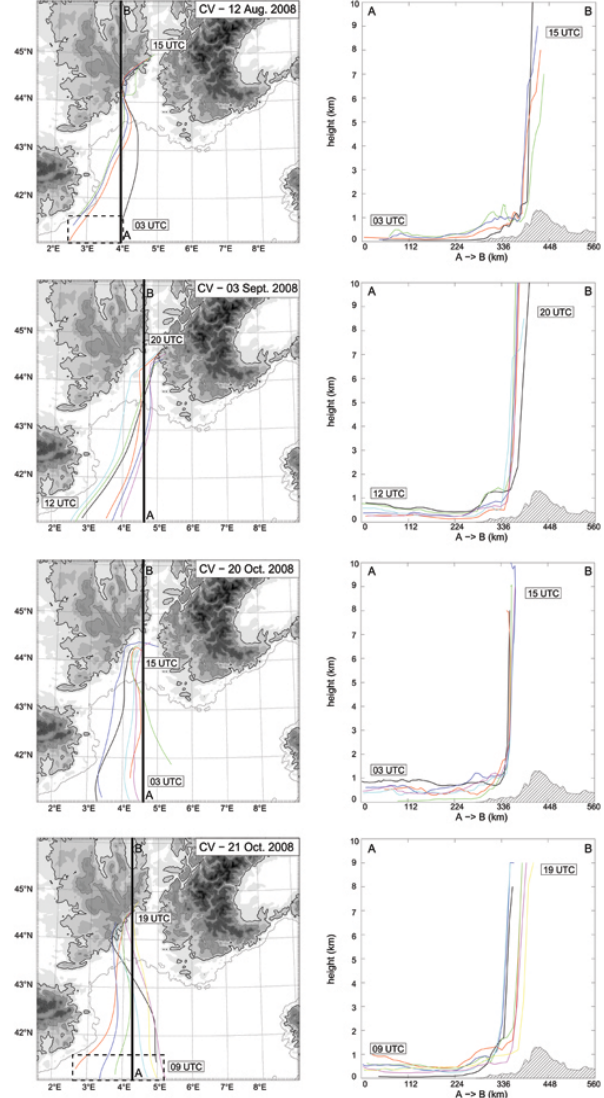
Fig. 7. Backward trajectories of some air parcels taken in the upper part of the precipitating systems simulated by HRA2.5 for four CV cases, the 12 August 2008 (top), the 3 September 2008 (middle top), the 20 October 2008 (middle bottom) and the 21 October 2008 (bottom) cases. The backward trajectories are projected both on an horizontal plane (left panels) and on a vertical cross-section (right panels). The vertical cross-section follows the line AB displayed on the left planels. The orography is superimposed in grey scale as in Fig. 2 for the left panels and as a hatched area for the right panels. The dashed rectangles in the top and bottom left panels delimit the areas used for the calculation of the average thermodynamic characteristics of the 12 August 2008 and 21 October 2008 low- level feeding inflow displayed Fig.